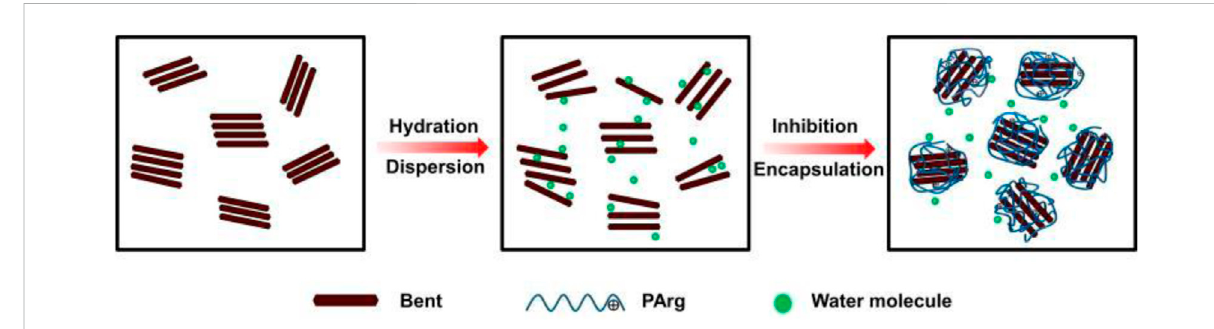
FIGURE 2 Schematic illustration of the inhibition mechanism of the inhibitor PARG on bentonite.